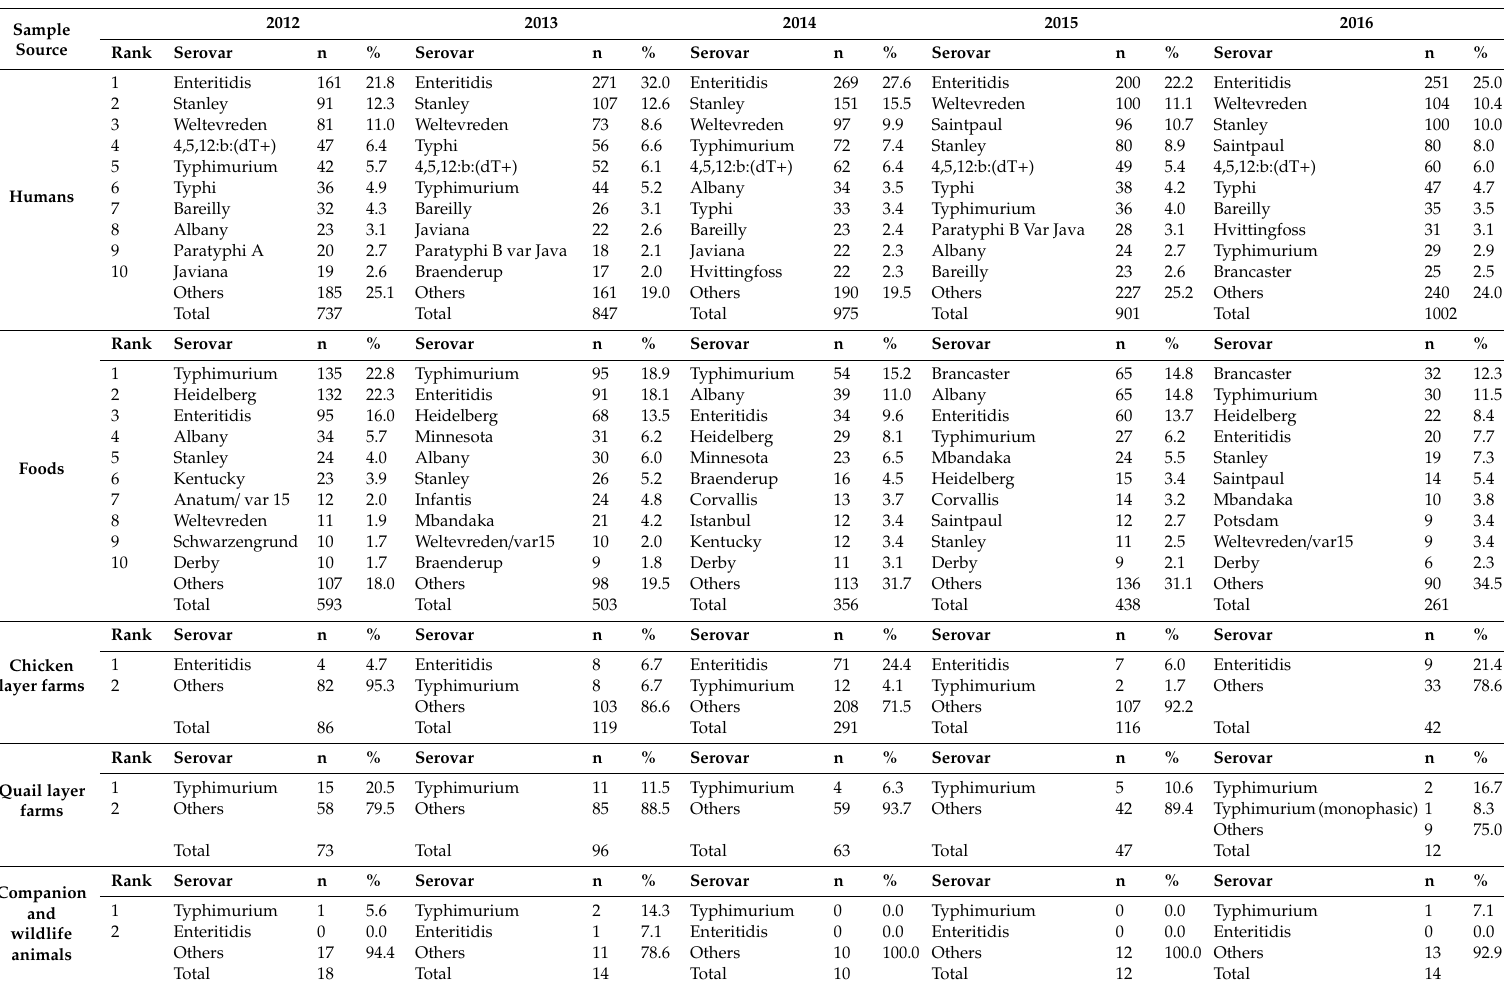
Table 2. Frequency of Salmonella serovars in humans, farms, foods, companion and wildlife animal samples in Singapore from 2012 to 2016. Sample